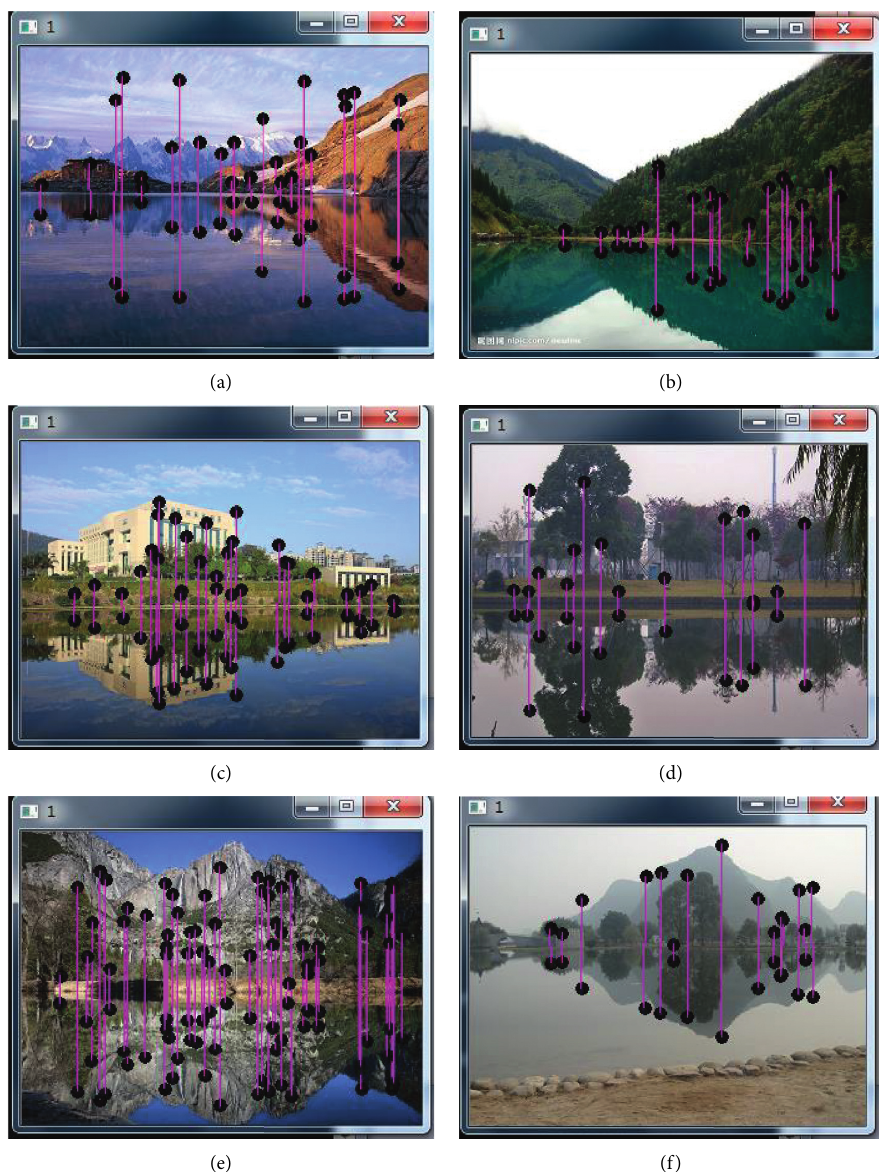
Figure 16: Symmetrical SURF points matching results of water